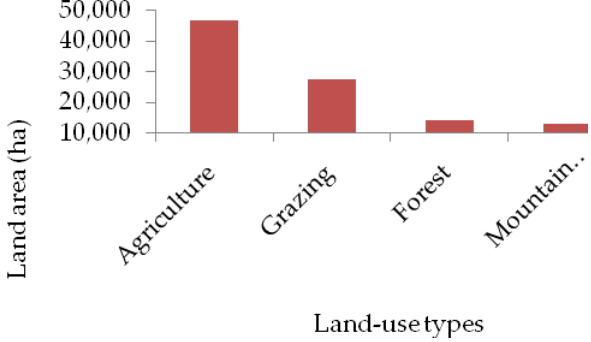
Figure 1. Land use types in the study areas.